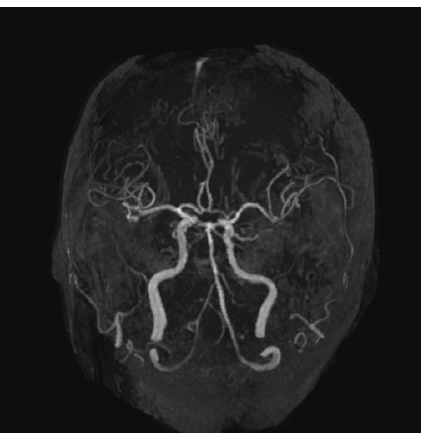
Figure 3: Magnetic resonance arteriography (MRA) before corti- costeroid therapy shows no finding of cerebral vasculitis.